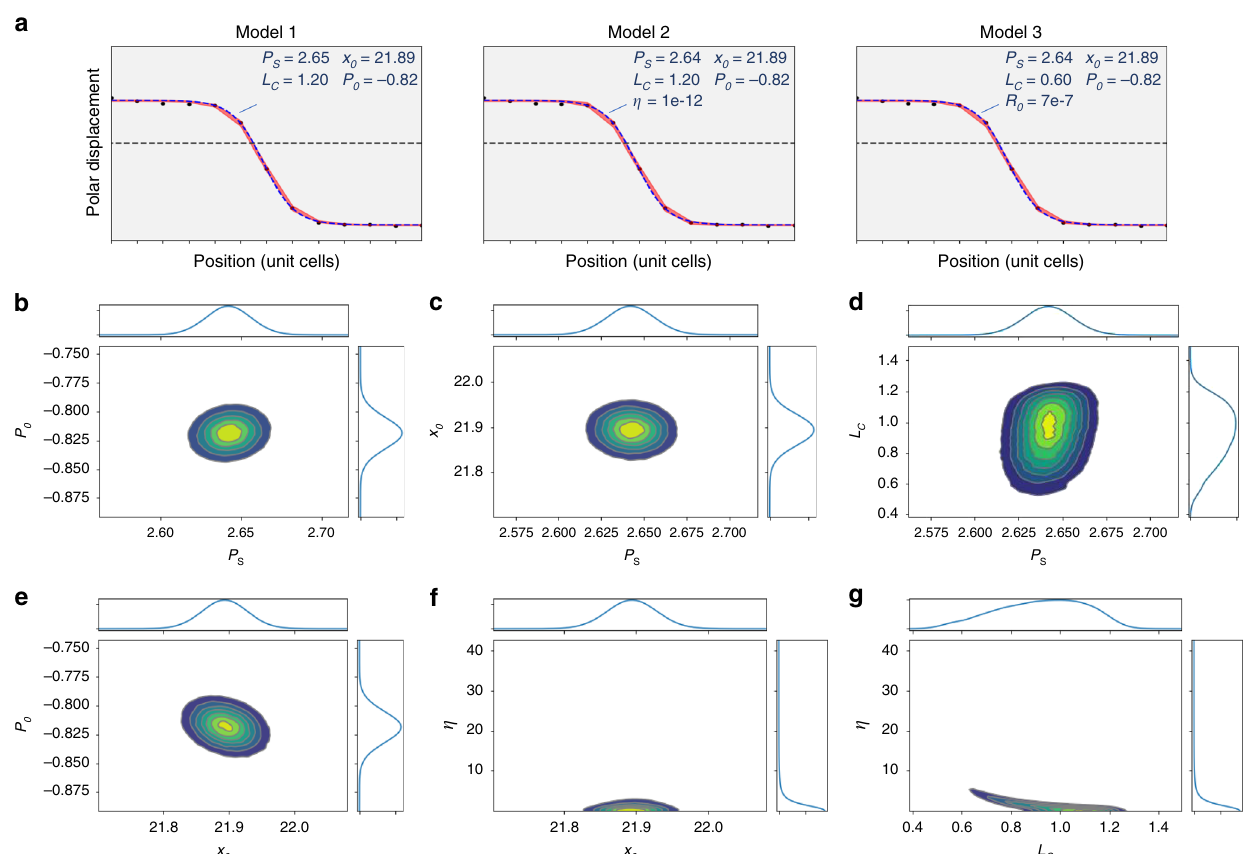
Fig. 5 180° Domain wall: GLD models and posterior probability densities. a The 90% highest posterior density interval for the Bayesian analysis (red band) overlaid on experimental mean values (data points). Dashed blue line is a least square fi t. b – g are selected 2D joint probability densities for different parameter combinations for model